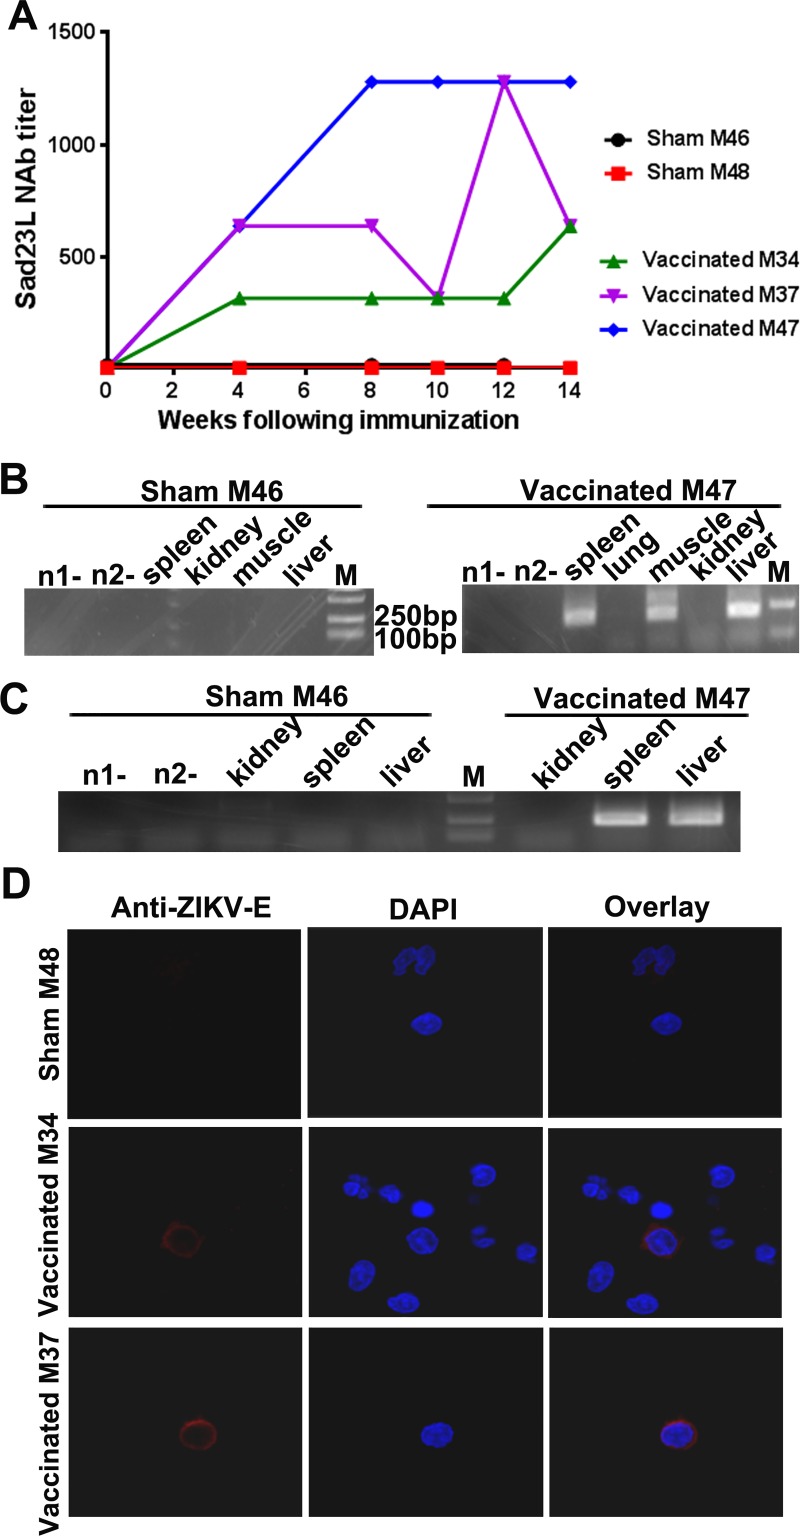
Biodistribution and expression of Sad23L-prM-E vaccine in marmosets.(A) Neutralizing antibody titers to Sad23L vectorial virus after prime immunization with Sad23L-prM-E vaccine. (B) Nested-PCR amplifying Sad23L-hexon gene (200bp) in tissues (spleen, lung, muscle, kidney and liver) at 16 weeks after prime immunization with Sad23L-prM-E vaccine. (C) RT nested-PCR amplifying ZIKV E mRNA transcripts in tissues (spleen, muscle, kidney and liver) of marmosets at 10 weeks (72 days) post challenge. (D) Immunofluorescence staining to detect the expression of E protein in PBMCs of immunized marmosets. PBMCs were isolated from marmosets in 4 months post challenge, stained by ZIKV E antibody and DAPI. Red immunofluorescence of ZIKV E protein was detected in vaccinated marmosets M34 and M37 but not in non-vaccinated sham marmosets M48.